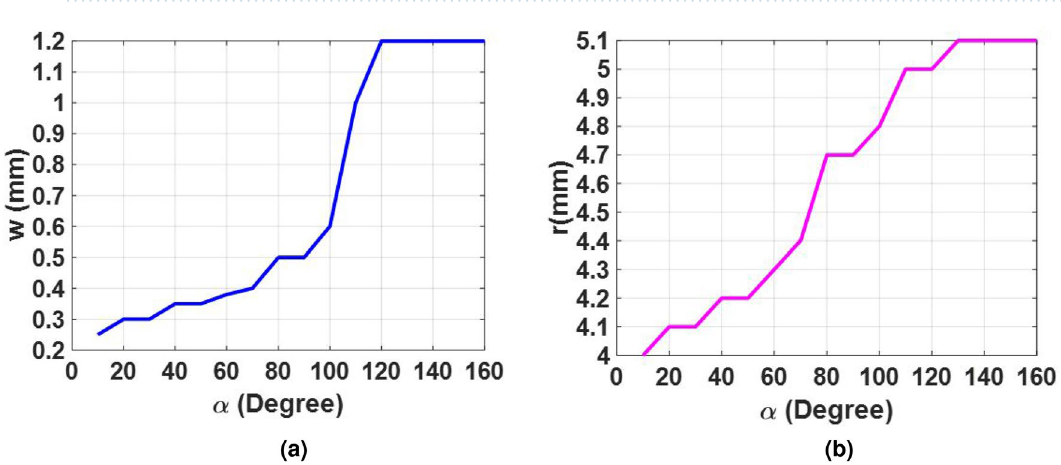
Figure 3. Optimum relation between the design parameters of the unit cell for realizing the wideband behavior in the cross-polarization mode. ( a ) Optimum variations of w when α is varied. ( b ) Optimum variations of r when α is